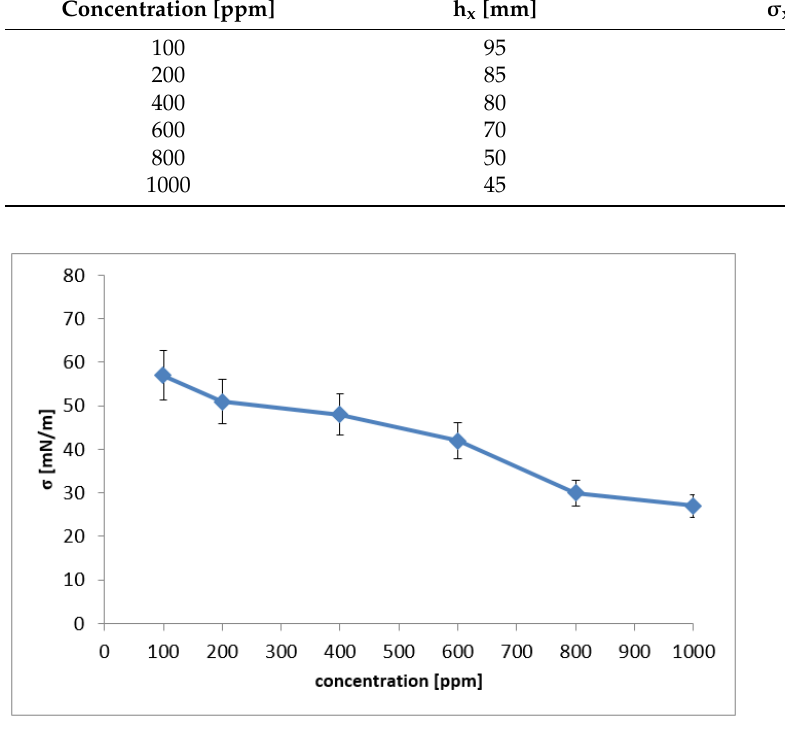
Figure 5. The variation of the surface tension versus the increasing solution concentration. Data are expressed as mean ± SD of three independent experiments. (- ♦ -) washnut water solution.